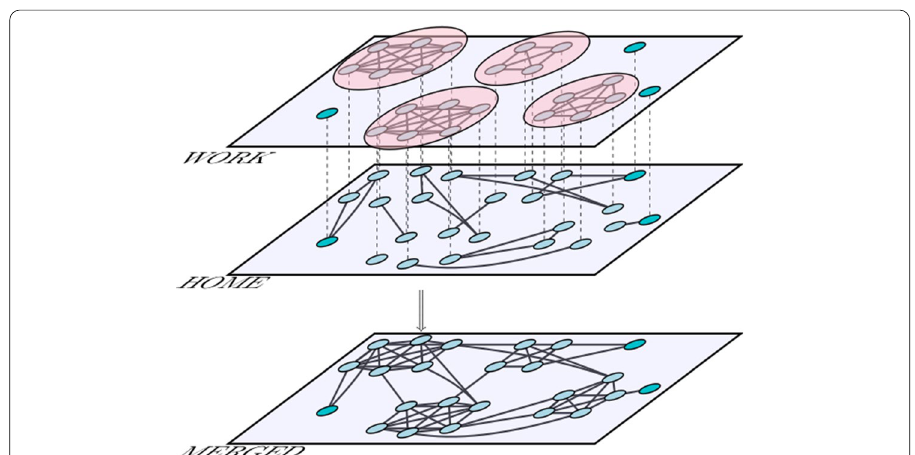
Fig. 1 Multiplex construction of the two basic and fixed sets of connections. Top layer corresponds to the Work construction formed by cliques of relative large size. Bottom layer corresponds to the Household construction formed by cliques of very small size. Dashed lines are drawn just to recall that the nodes in the two layers correspond to the same individual. Merging these two layers into a single one results in a larger component, as shown in the single merged layer in the bottom of the